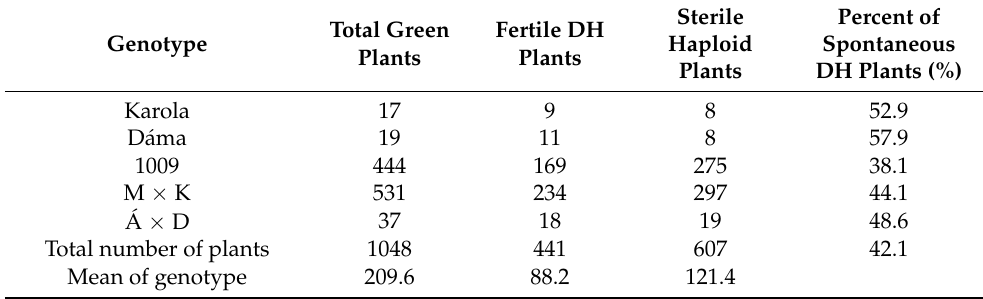
Table 5. Rate of spontaneous DH plants detected at the nursery field of MATE (Szarvas).